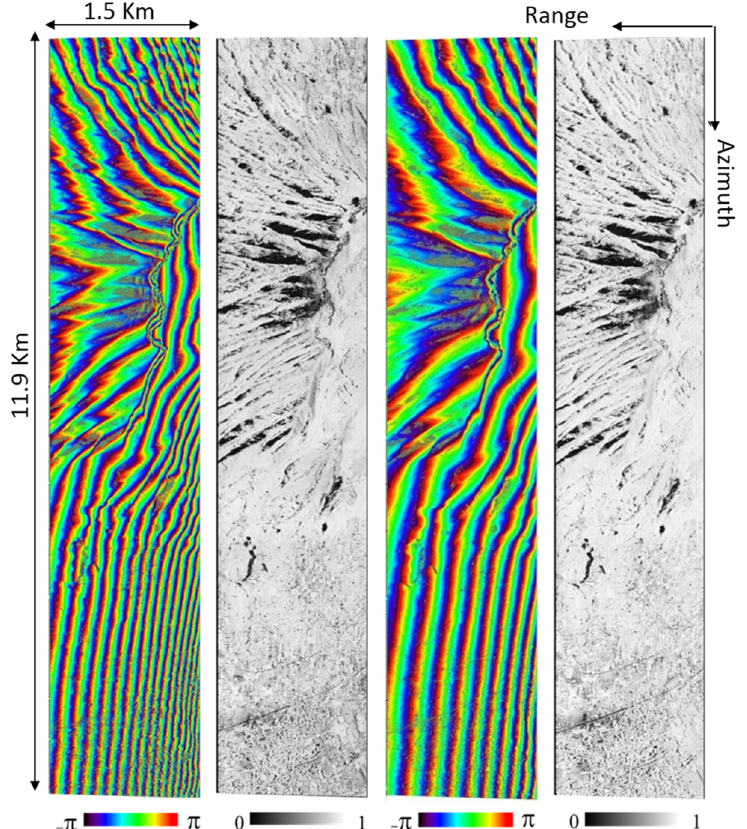
Figure 5. Two interferograms and the corresponding coherence maps relevant to the frame 2 of Figure 3a (400 MHz mode, multi-baseline configuration). Left panels refer to the data pair acquired with the largest XT baseline (height of ambiguity ranging from 44 m to 124 m). Right panels refer to the data pair acquired with the smallest XT baseline (height of ambiguity ranging from 87 m to 196 m). The applied pixel averaging is described in the body of the paper.